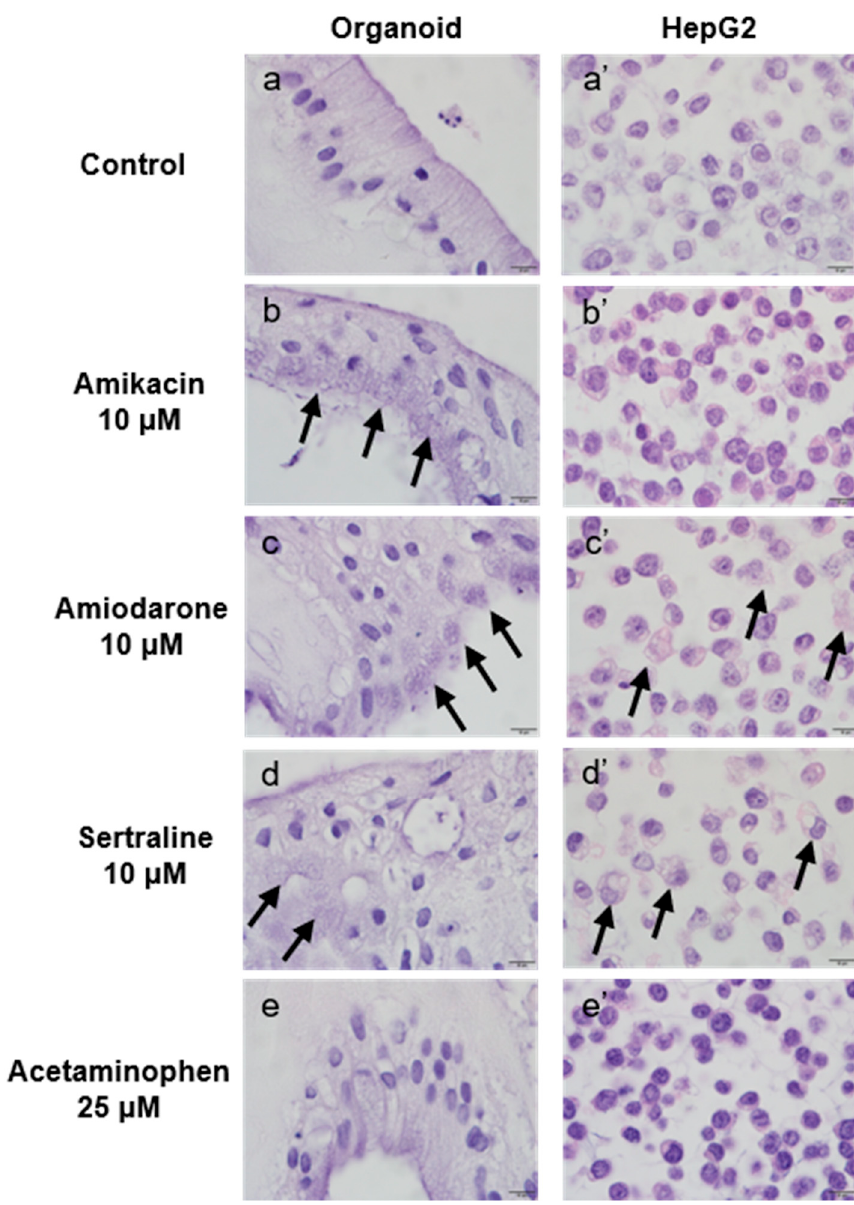
Figure 7. Microscopic evaluation of morphological changes in organoids and HepG2 cells following incubation with the indicated agents. Organoids ( a – e ) and HepG2 cells ( a’ – e’ ) were treated with phospholipidosis (PL)-inducing drugs or untreated for 48 h as follows: Control (untreated) ( a , a ’), 10 μ M amikacin ( b , b ’), 10 μ M amiodarone ( c , c ’), 10 μ M sertraline ( d , d ’) and 25 μ M acetaminophen ( e , e ’). Arrows indicate PL-induced cytoplasmic vacuolation. Original magnification, ×1000. Bar indicates 10 μ m.